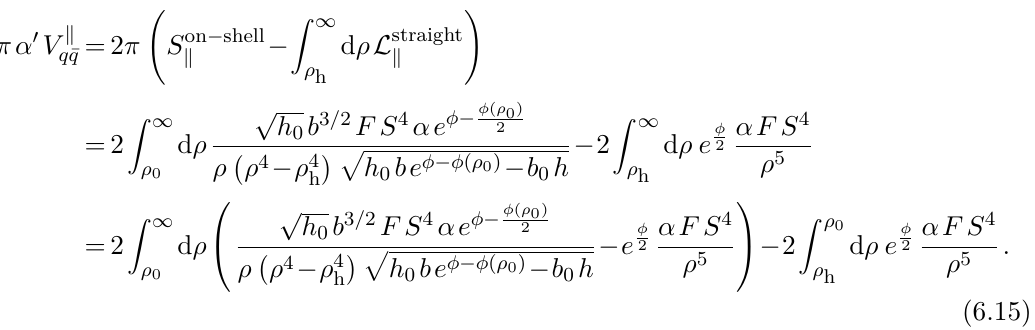
strings going straight from ρ = ρ to the boundary at ρ → ∞ . The regularized on-shell h action is identified with the quark-antiquark potential. We